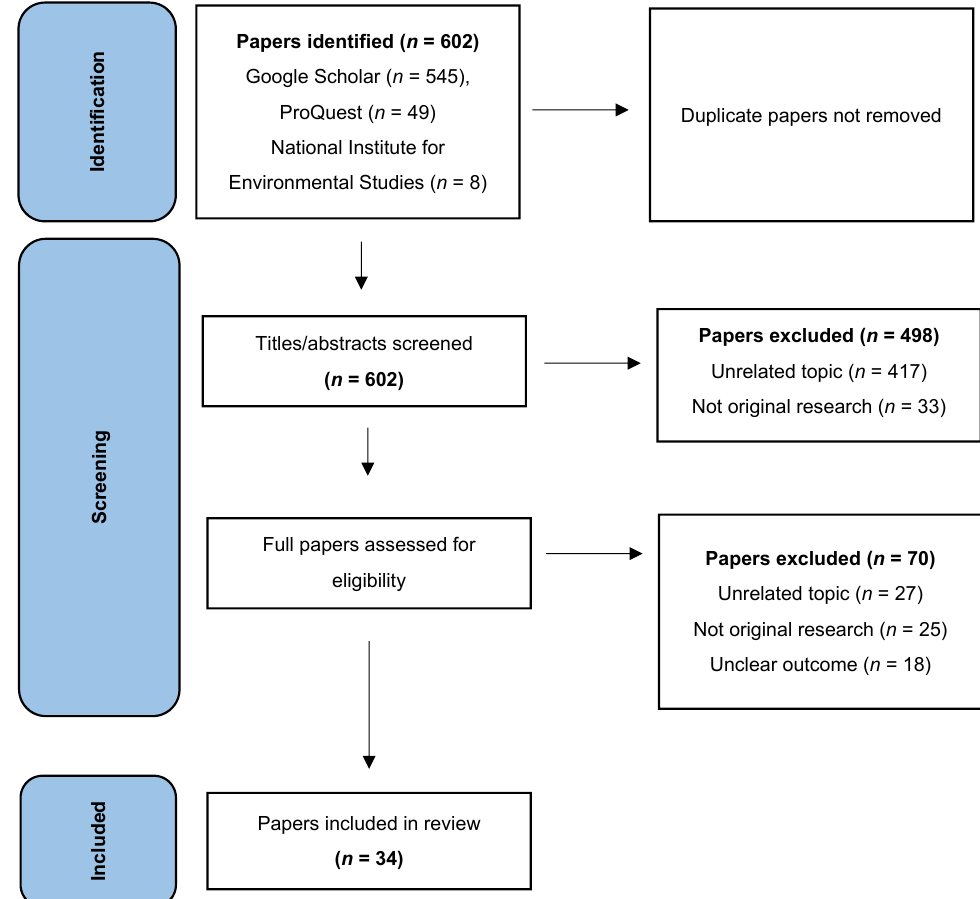
Figure 1. Identification of papers from databases.